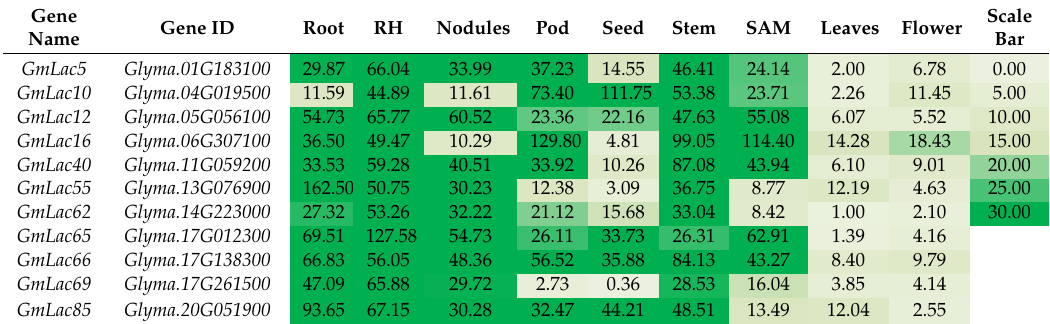
Table 1. Constitutively expressed laccase genes ( GmLac ).